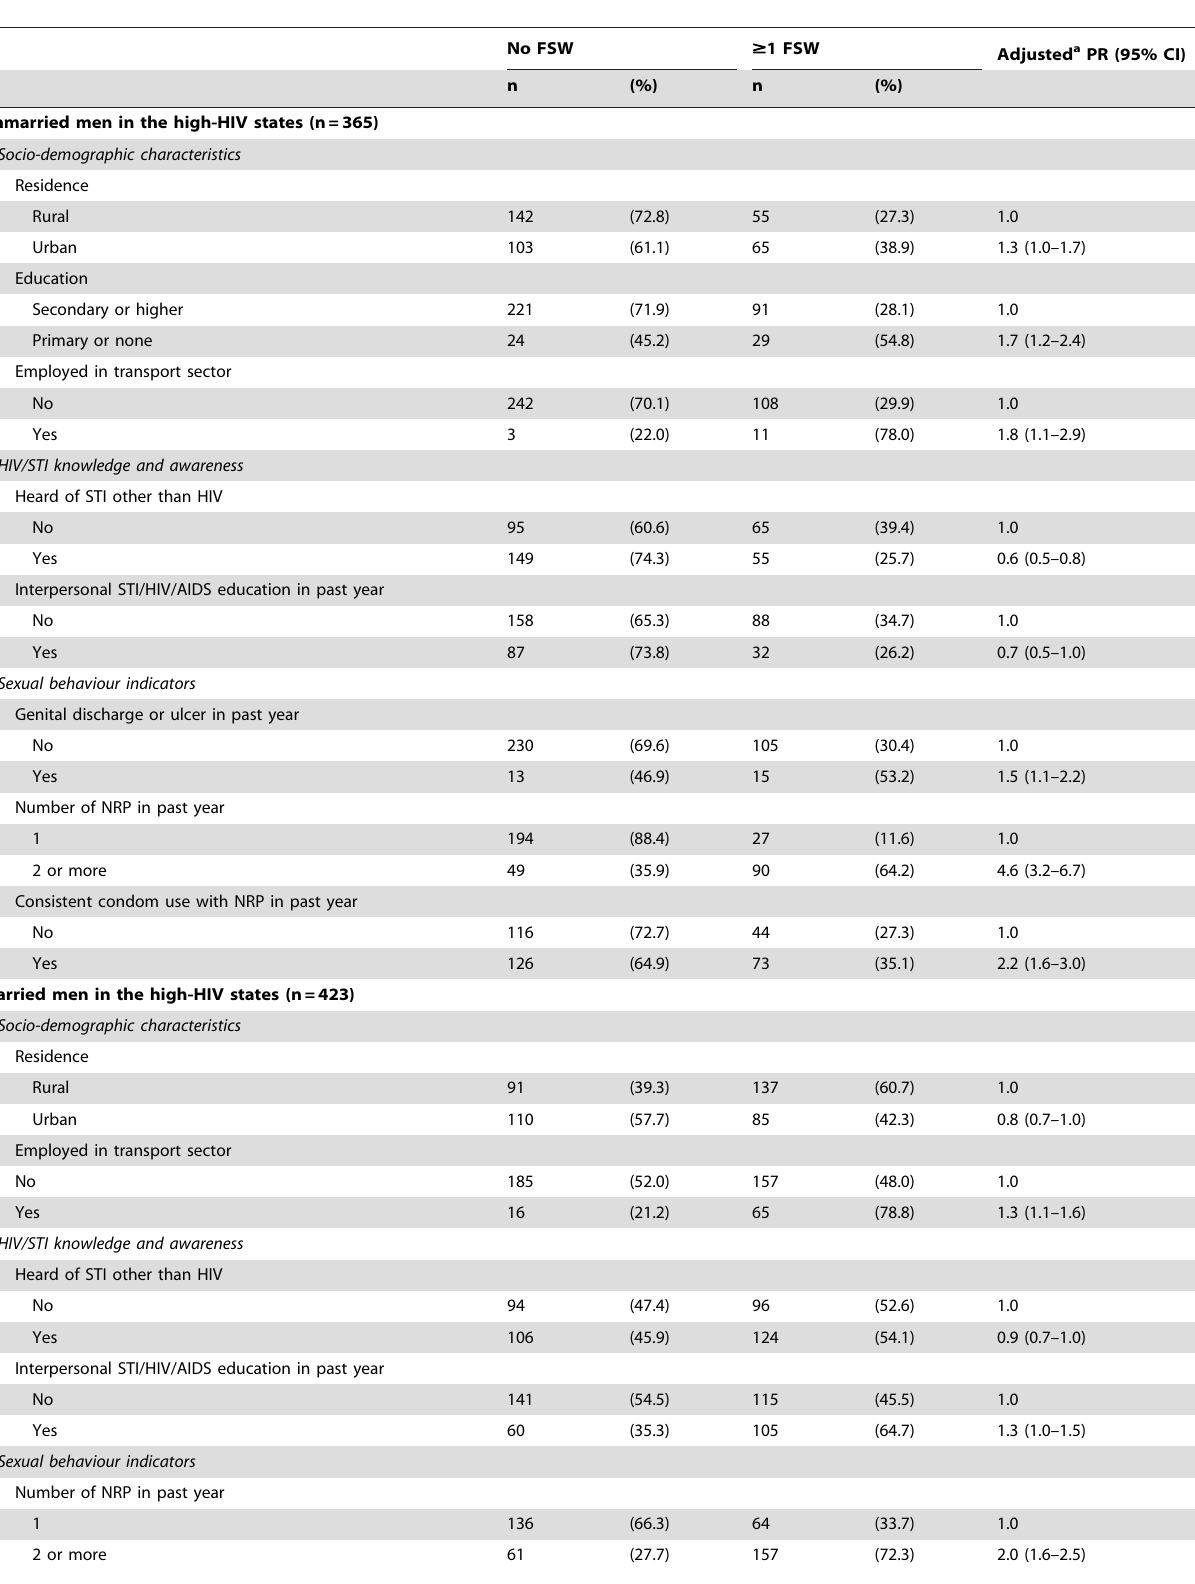
Table 3. Factors associated with using female sex work among Indian men reporting any non-regular partner in the past year in the high-HIV states,